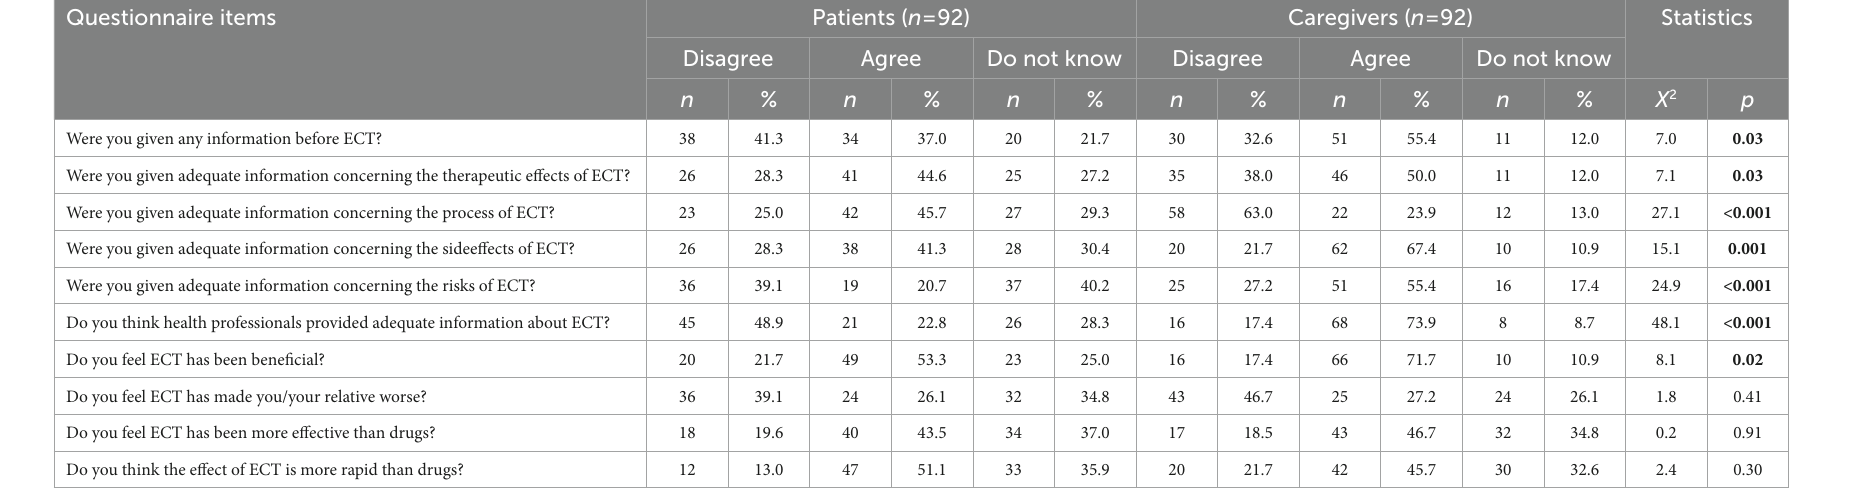
TABLE 2 Electroconvulsive therapy knowledge and perceptions of patients and their caregivers. Questionnaire